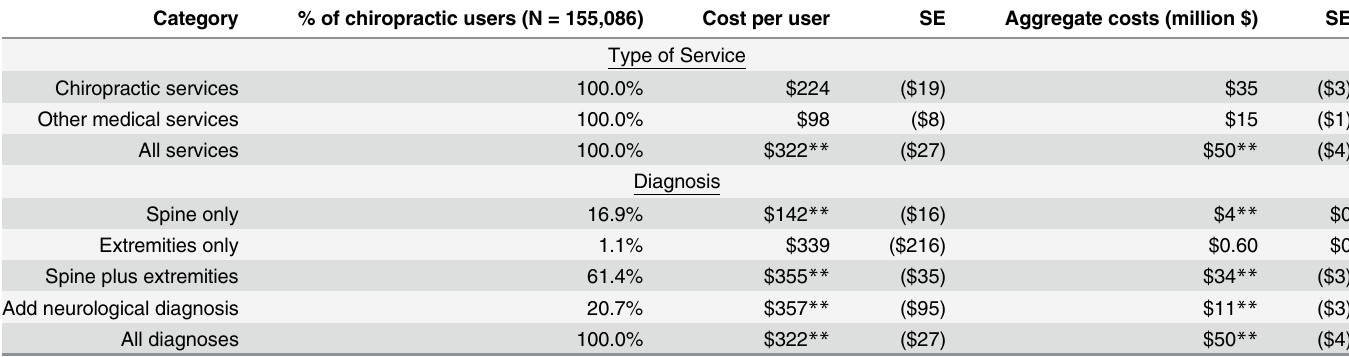
Table 3. Increases in Medicare Costs in Chiropractic Users by Type of Service and Diagnosis over the 2 Years of the Demonstration.